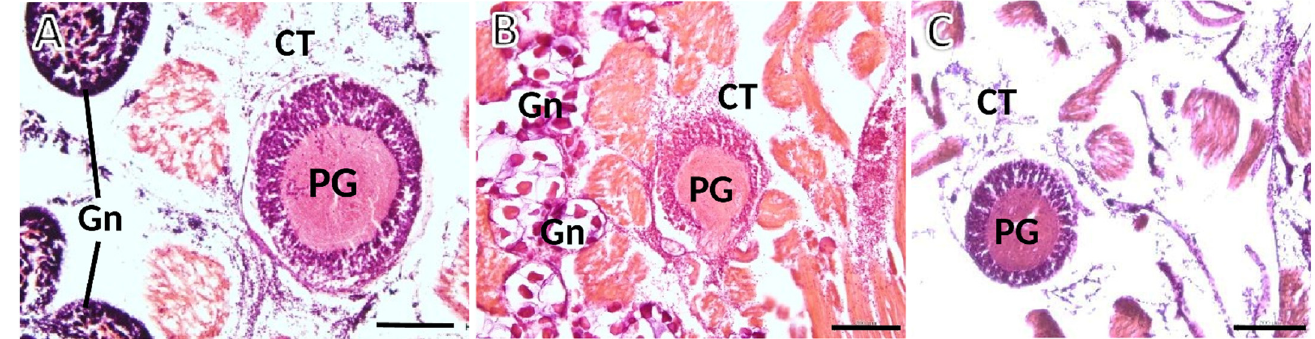
Figure 4. Photomicrographs taken from thick histological sections of ganglia of S. plana . ( A ) Male: spermatogenesis is evident within the gonadal acini (Gn); at the upper and lower left corners of the image. ( B ) Female: gonadal acini (Gn) are filled with roundish maturing oocytes. ( C ) Image from one undifferentiated animal, with atrophic acini devoid of maturing gametes, occasionally appearing dispersed in the connective tissue (CT). PG—Pedal ganglion. Six animals per sex were used. H&E staining. Scale bar: 200 µm.